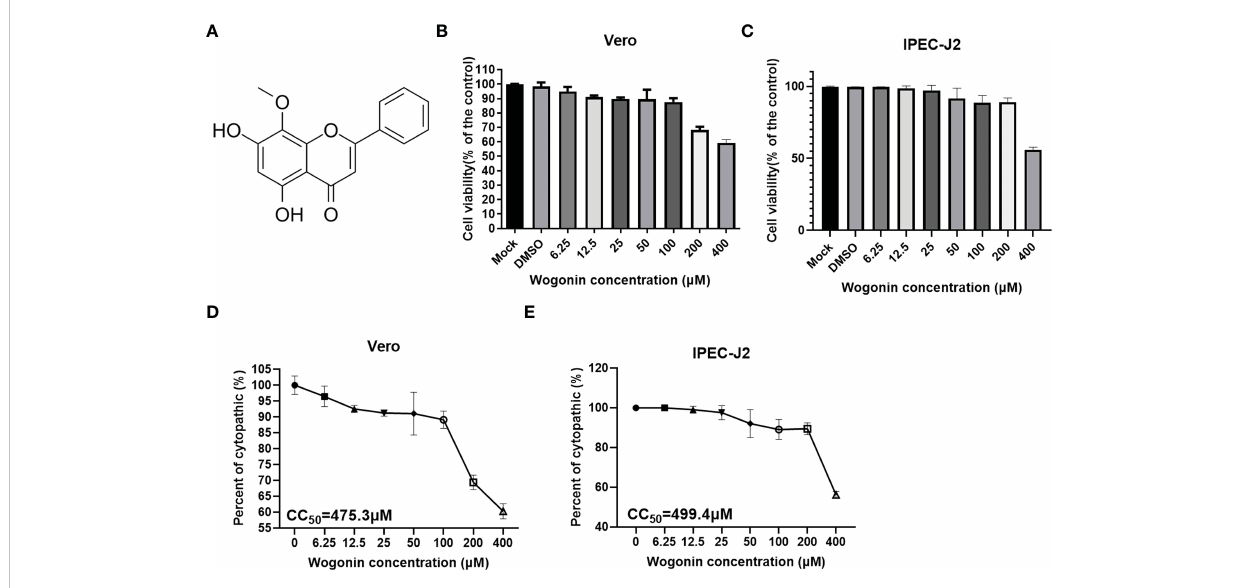
FIGURE 1 Cytotoxicity of wogonin on Vero cells. (A) Structure of Wogonin. (B, C) Evaluation of cell viability using CCK-8 assay. All the values were normalized to the control group, representing 100% cell viability. The Vero (B) and IPEC-J2 (C) cells were treated or not treated with wogonin at 48 h. Representative results of at least three independent experiments have been indicated. (D, E) CC50 values were calculated using GraphPad Prism software 7.0.